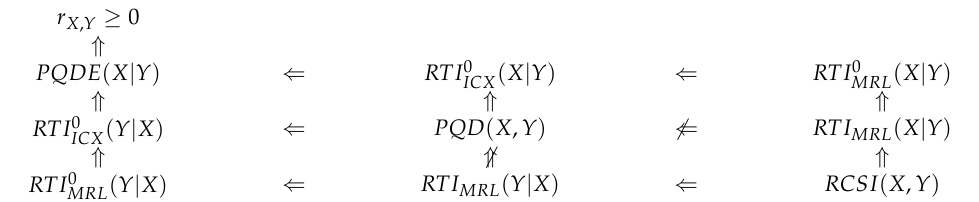
Table 4. Relationships among weak positive dependence